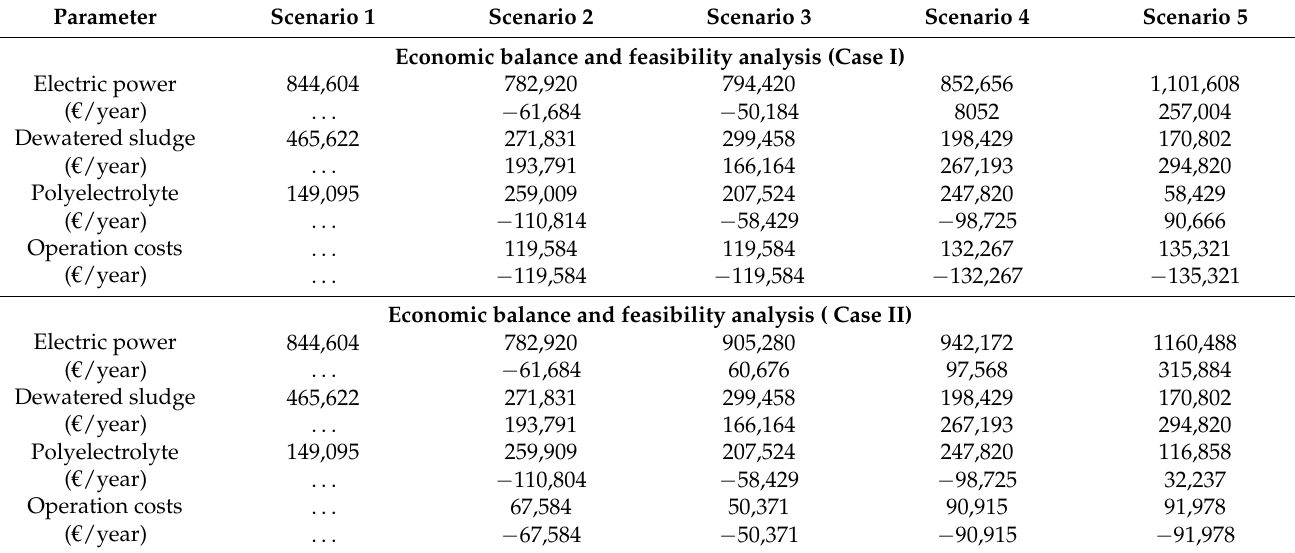
Table 10. Economic balance and feasibility analysis for Cases I and II. The second row corresponds to the increment obtained when compared with Scenario 1. A negative sign represents a